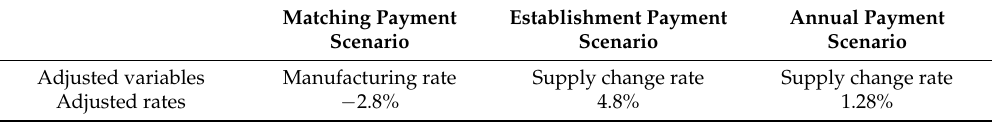
Table 1. Scenarios and key economic